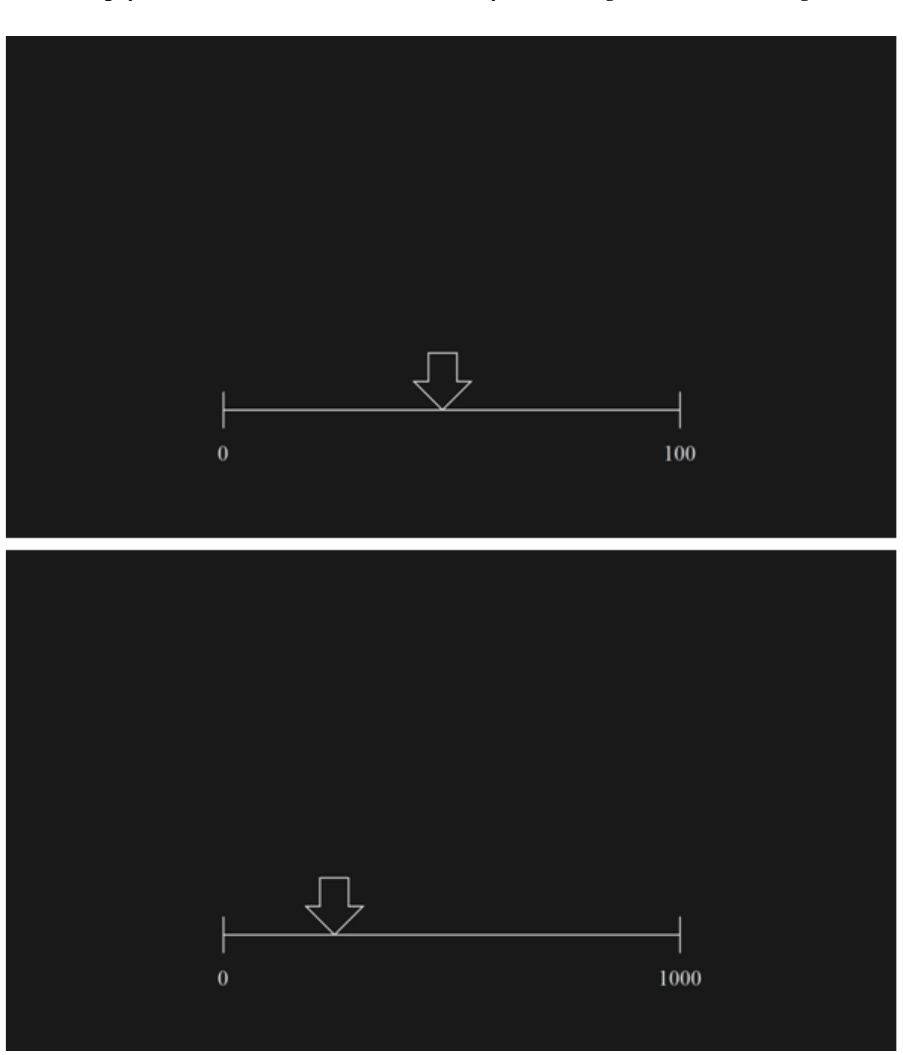
Figure 1. Examples of stimuli used in the tasks that required verbal estimation of the number magnitude pointed by an arrow on the empty number line: 0 – 100 ( top ) and 0 – 1000 ( bottom ).